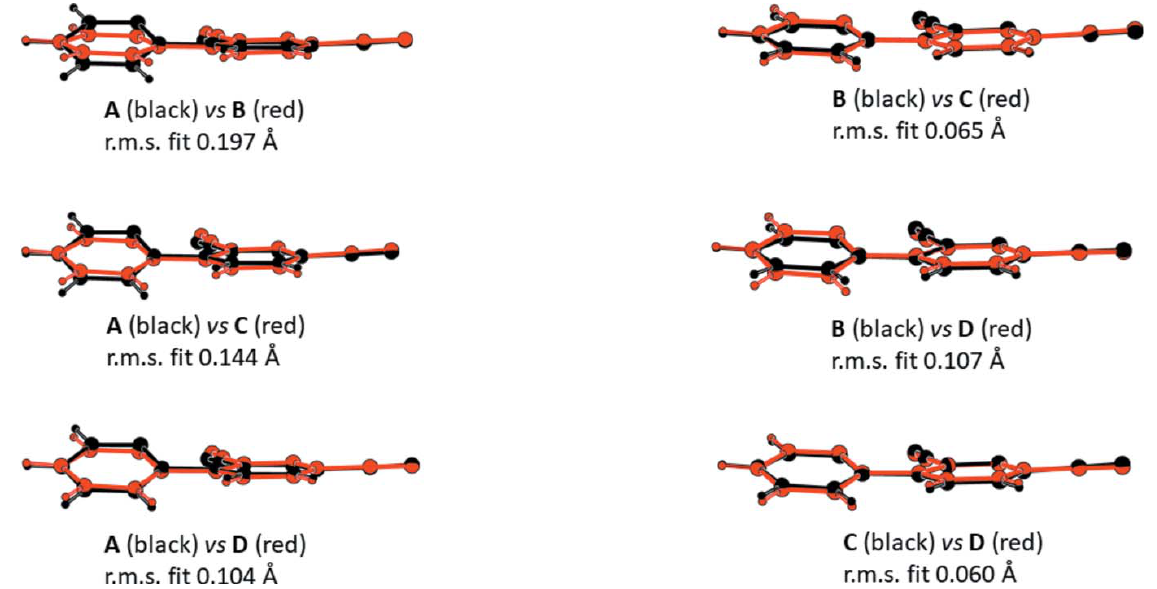
Figure 2 The overlay fits of the various molecules in the asymmetric unit of the title compound.